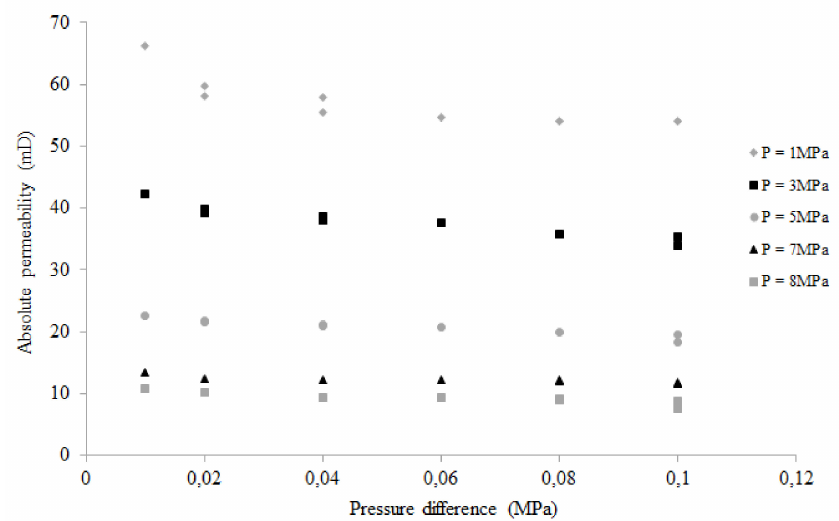
Figure 5. Dependence of the gas permeability coefficient of the coking coals (S. D. Tihov mine, Leninsky area, Kuzbass) (k) on their pressure difference ( ∆ P) and confining hydrostatic pressure (P).